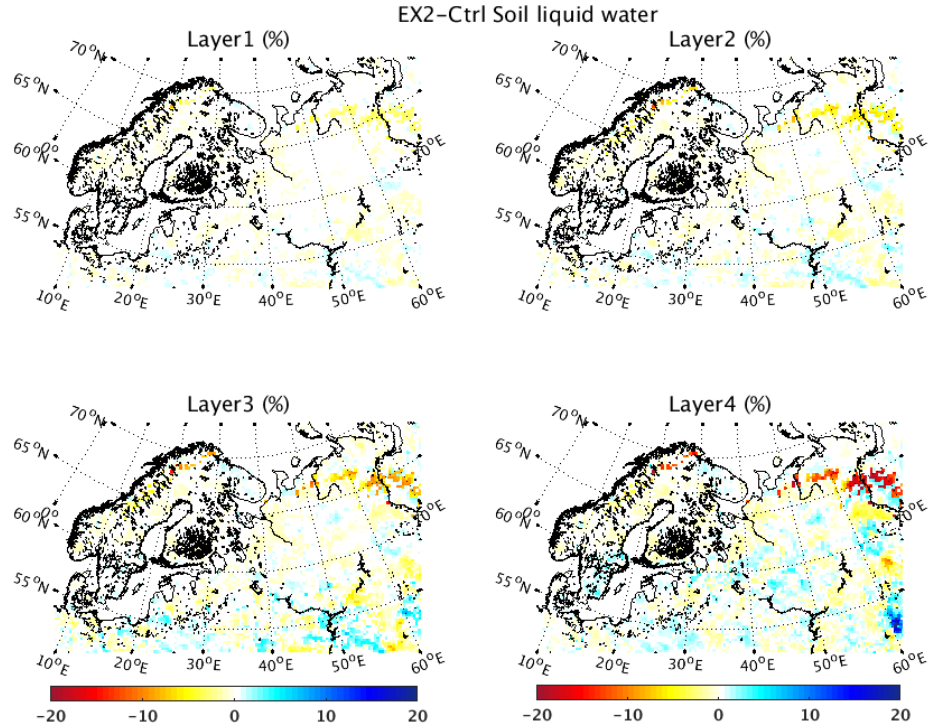
Figure 9. Percentage change in 10-year average volumetric liquid water soil content for each soil layer, as the difference between Ex 2 and the control run. Note that red indicates dryer conditions, and blue wetter conditions as compared to the control run (only showing significant results at the 95% confidence